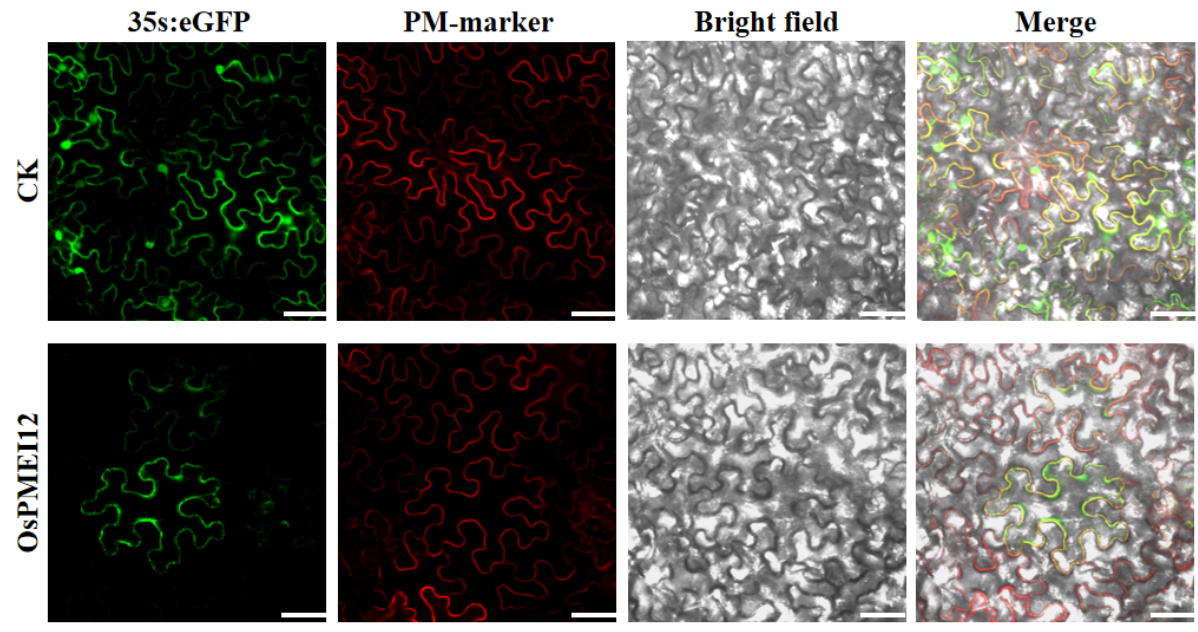
Figure 3. Subcellular localization of OsPMEI12 overserved with confocal microscopy. CK: PD1301s-eGFP no-load with plasma membrane marker transformation; OsPMEI12: pD1301s-eGFP-OsPMEI12 is co-transformed with PM-marker. Scale bars: 30 µm. Table 1. Agronomic traits of pmei12s and WT. Tiller Number Total Number of Panicles Effective Panicles Plant Height (cm)